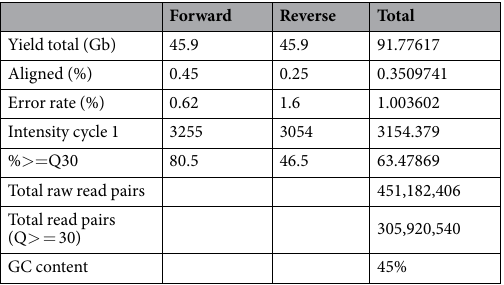
Table 1. Spiny mouse RNA-Seq summary